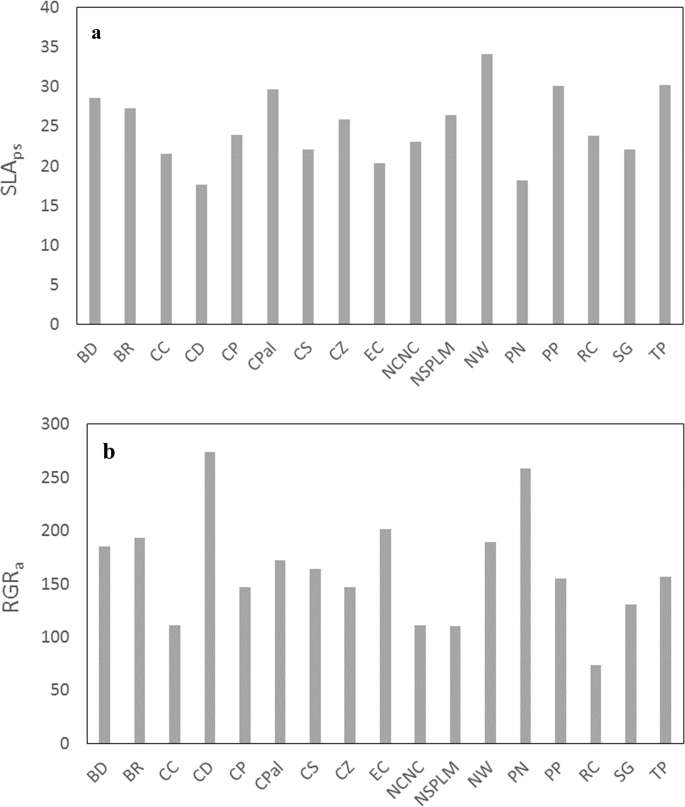
Aboveground specific leaf at the leaf scale (SLAps) (a) and aboveground relative growth rate (RGRa) (b) for the seventeen species of the dataset.